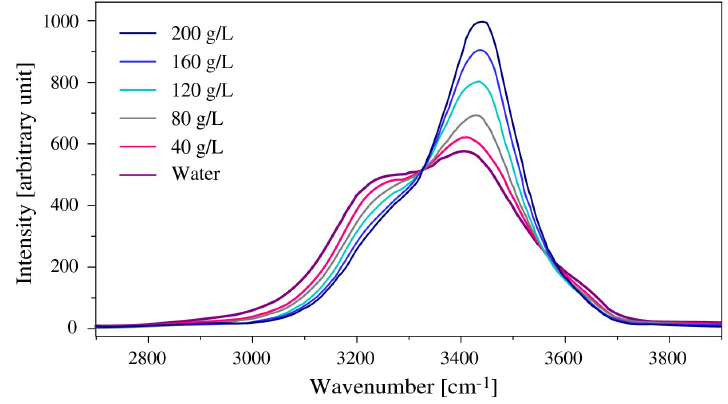
Figure 2. Concentration effect of the O − H stretching region on a Raman spectrum at 20